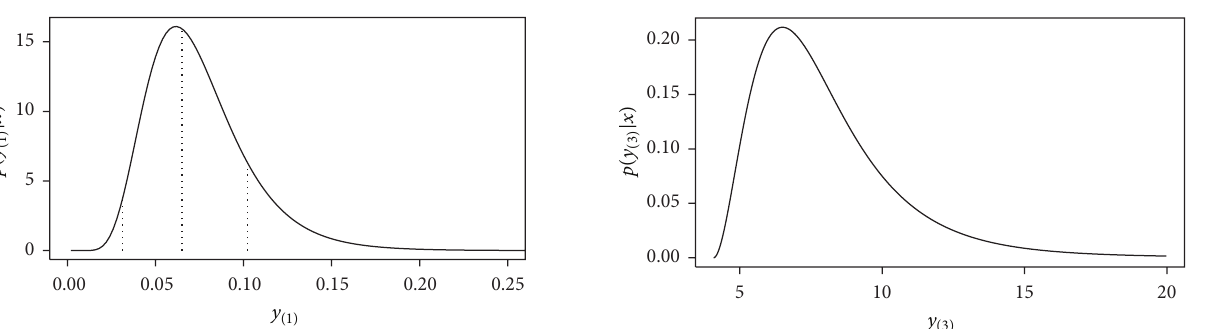
Figure 5: One-sample predictive density function when 𝑆 = 3 and 𝑟 = 20 for real data set.